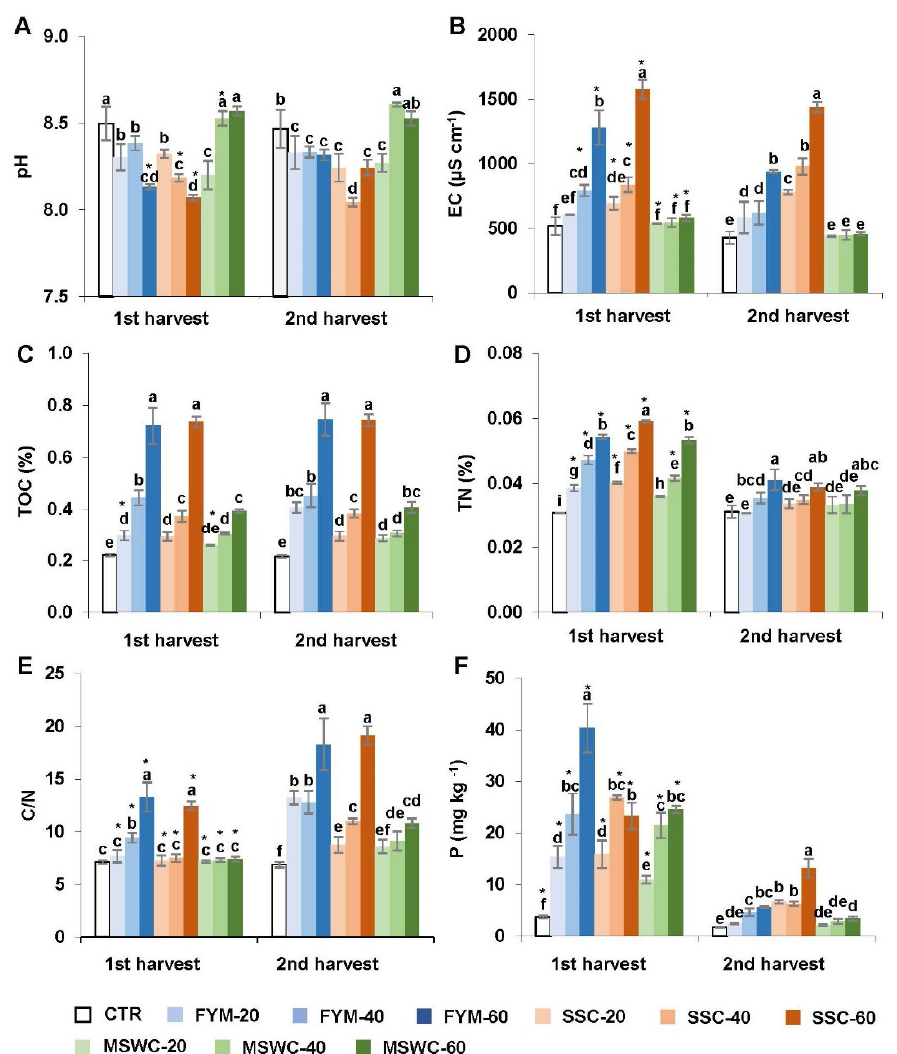
Figure 1. Soil physicochemical parameters: ( A ) pH, ( B ) electrical conductivity, ( C ) total organic carbon, ( D ) total nitrogen, ( E ) C/N ratio and ( F ) available P in unamended and amended soils. Lower case letters indicate significant differences between treatments within the same harvest time. Asterisks indicate a significant difference between harvest times within each treatment over time (* p < 0.05).